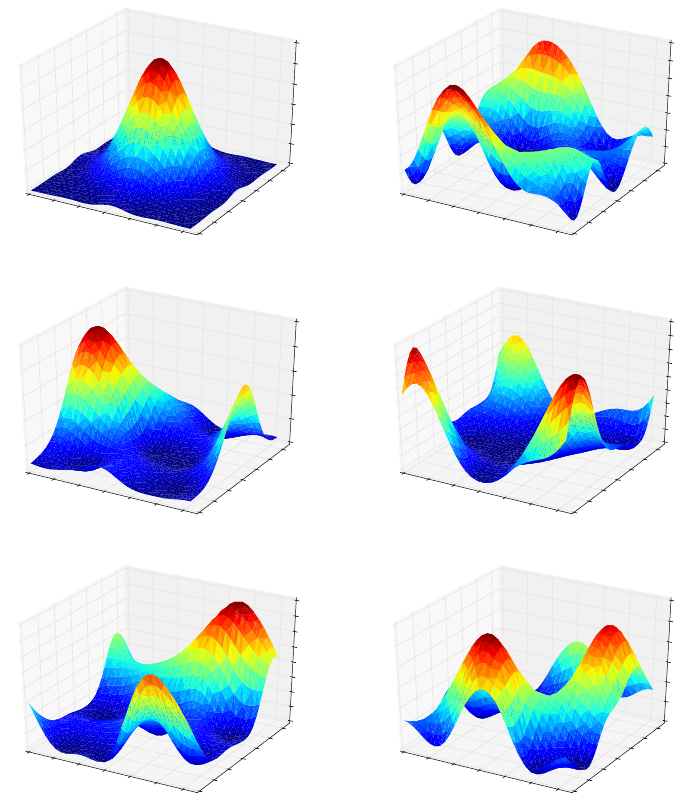
Figure 1. Lowest-lying pure U(1) eigenmode probability densities of the lattice Laplacian operator in a constant background magnetic field oriented in the ˆ z direction are plotted as a function of the x ,y coordinates. The origin is at the centre of the x − y plane. As k B = − 3 k d , the degenerate eigenmodes for the sixth quantised field strength relevant to the proton for k d = 2 are displayed in a linear combination that maximises the overlap of the first mode with the